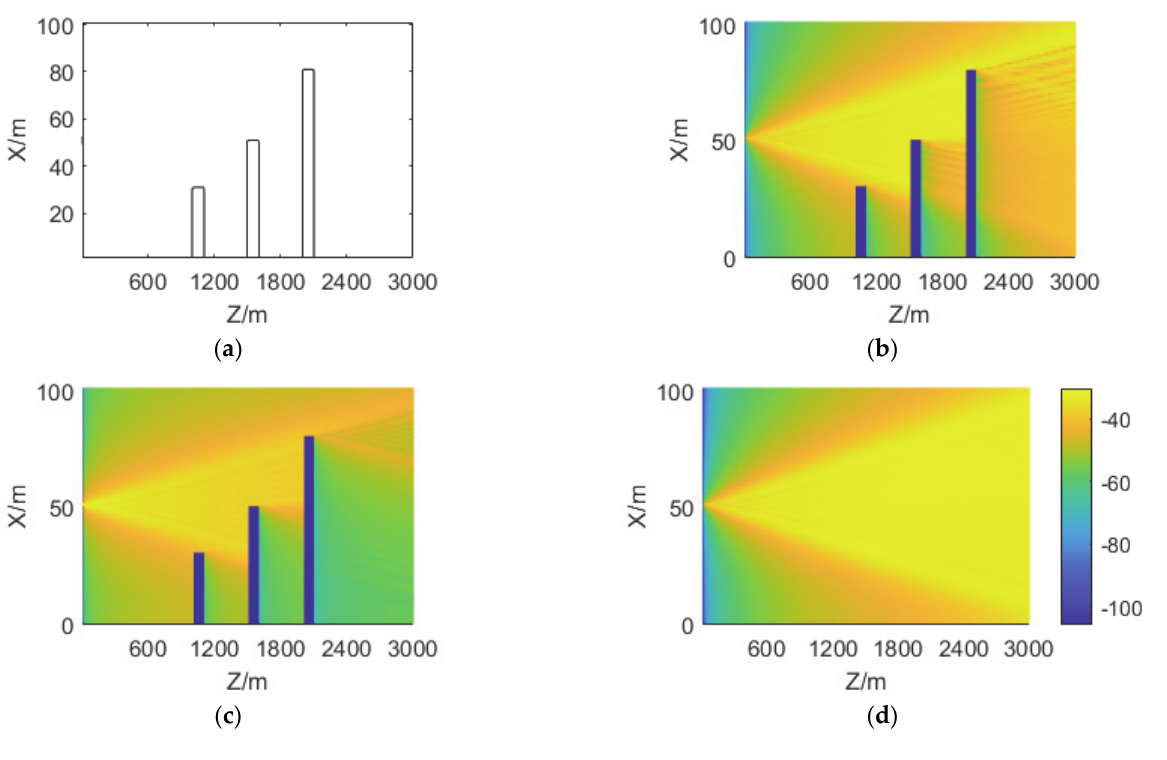
Table 1. The comparison with different sizes of cubes.